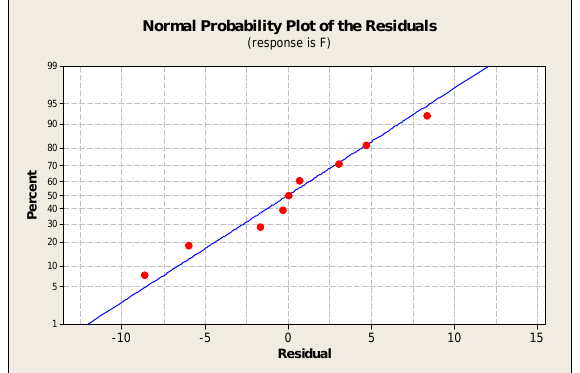
Fig. 2. Anderson Darling test for normality for cutting temperature (T)